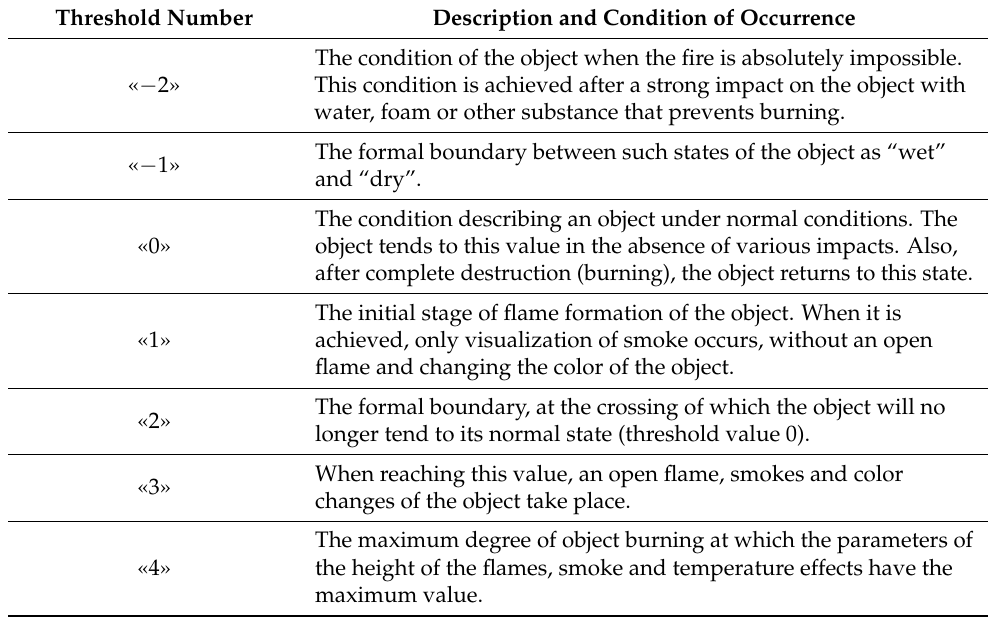
Table 1. Threshold values of burning